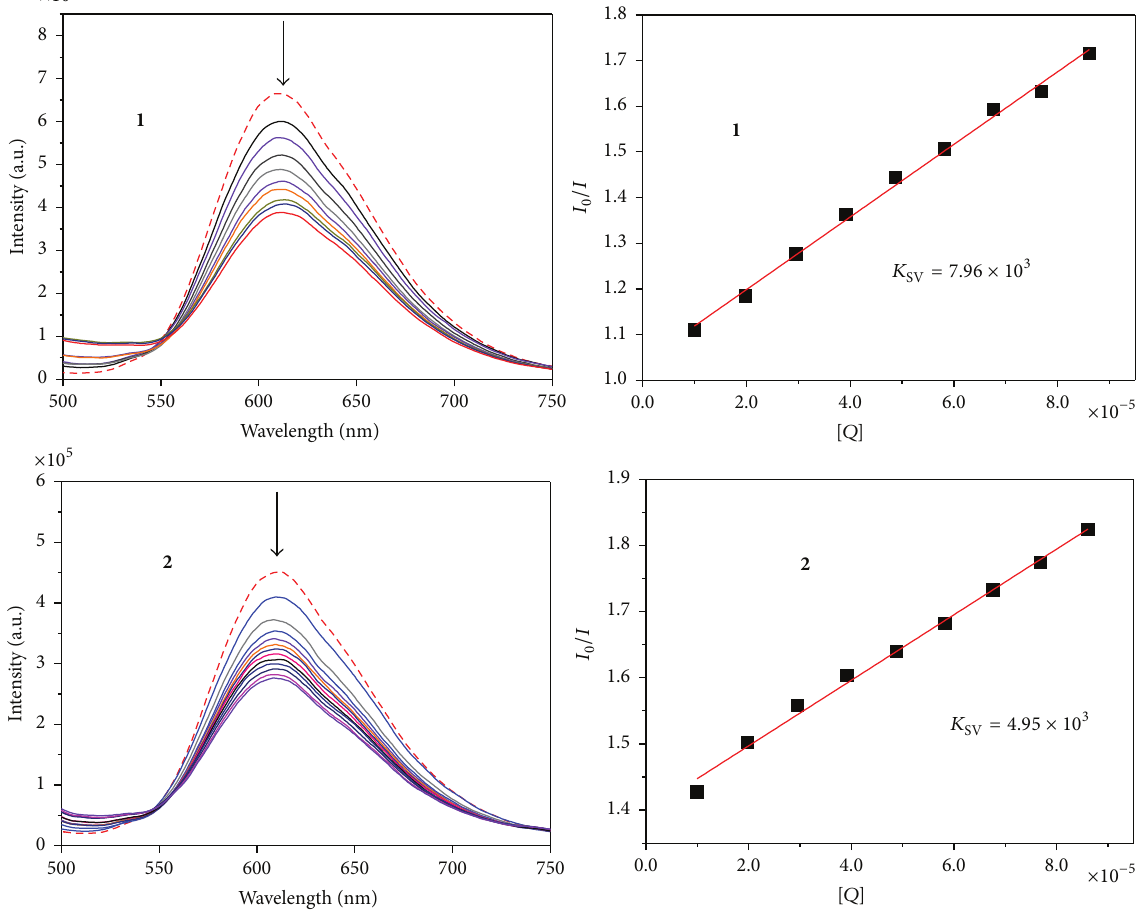
Figure 5: Fluorescence emission spectra of EthBr bound with G4-DNA ([DNA]/[EthBr] = 10: 1) in the absence (----) and presence (—) of increasing amounts of complexes 1 and 2 with [complex]/[EthBr] ratios ranging from 0 :1 to 10 :1, excited at 453 nm. shown to intercalate with nucleotides. EtBr showed